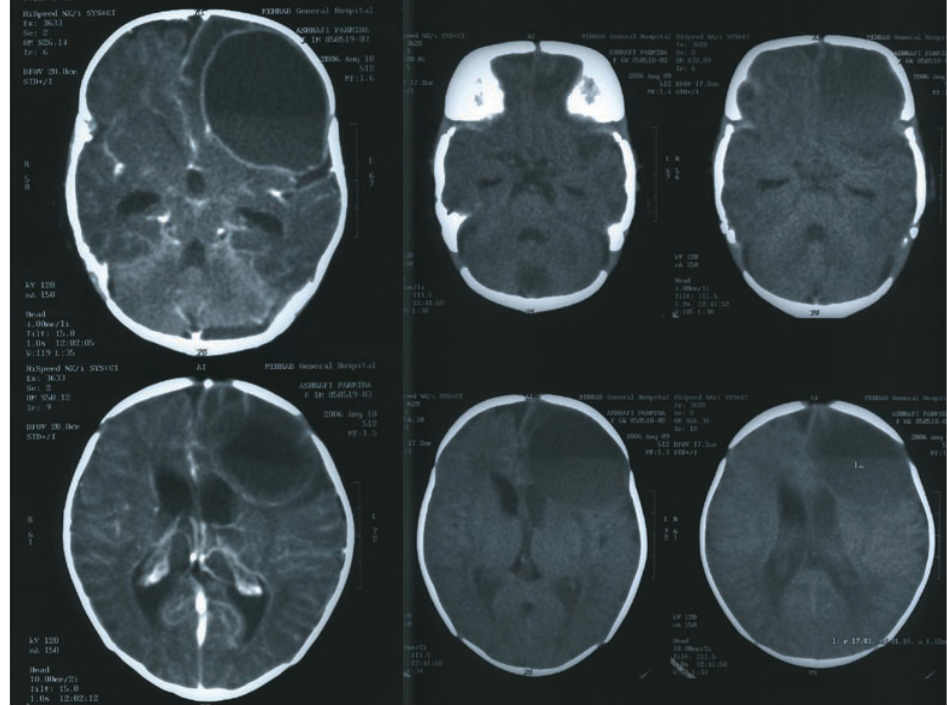
Figure 1. Brain CT scan with (left) and without (right) contrast of the infant girl, which shows a large cerebral abscess in the left frontoparietal lobe.